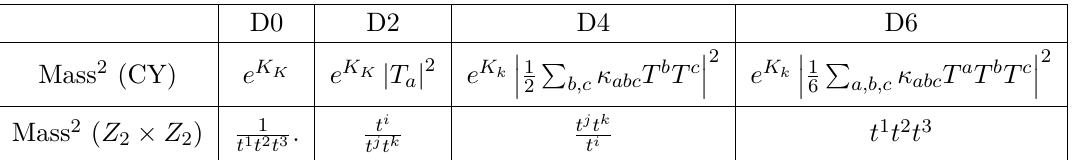
Table 1 . Masses of the different particles obtained by wrapping one kind of Type IIA D p -brane around a given even cycle on a general Calabi-Yau threefold and for the Z 2 × Z 2 orbifold example from ref. [20]. Masses are in units of 8 πM 2 p